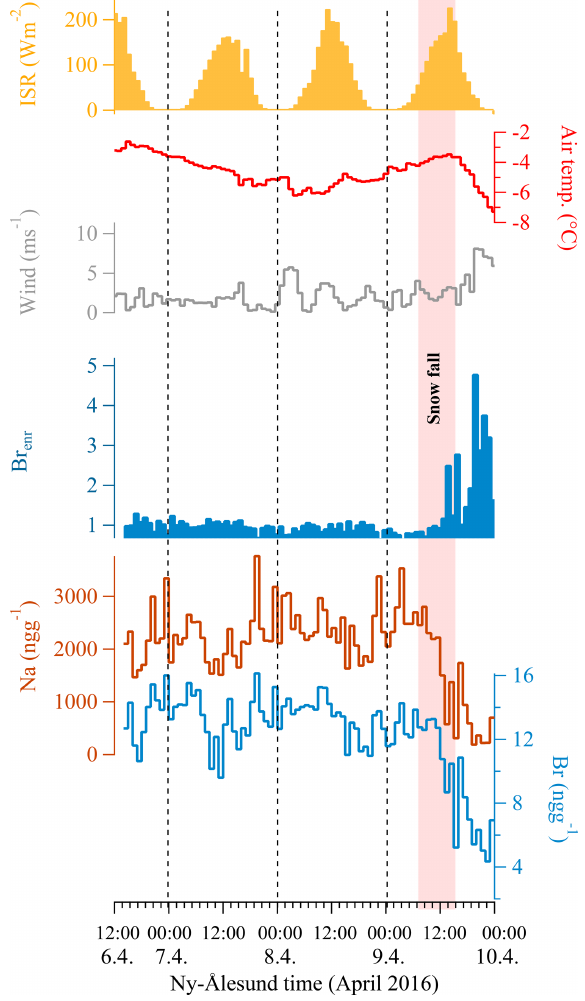
Figure 6. Surface bromine recycling during the 2016 experiment. The bromine concentration (light blue line) does not show diurnal variability and follows the sodium surface concentration (dark red line). The bromine enrichment factor (blue solid line calculated as Br enr = Br snow /( Na snow × 0 . 006 ) where 0.006 is the Br / Na seawa- ter mass ratio) does not show a diurnal cycle, but it is evident that snowfall effects the bromine concentration and its enrichment fac- tor during snowfall (pink shading). Air temperatures do not show a pronounced diurnal cycle (red line) connected with the incoming solar radiation (solid yellow). Dashed vertical lines indicate local